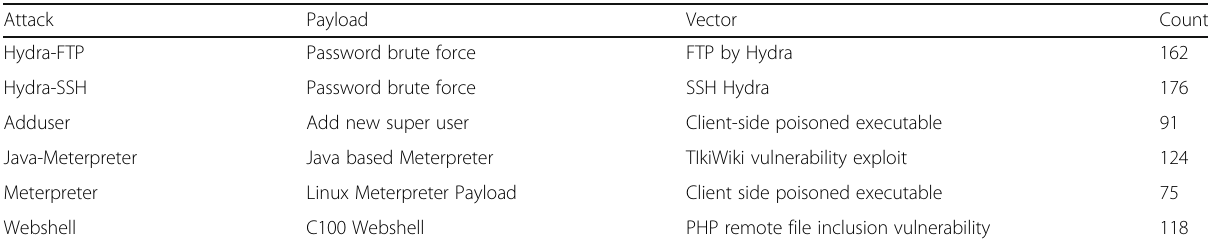
Table 10 ADFA-LD attack class